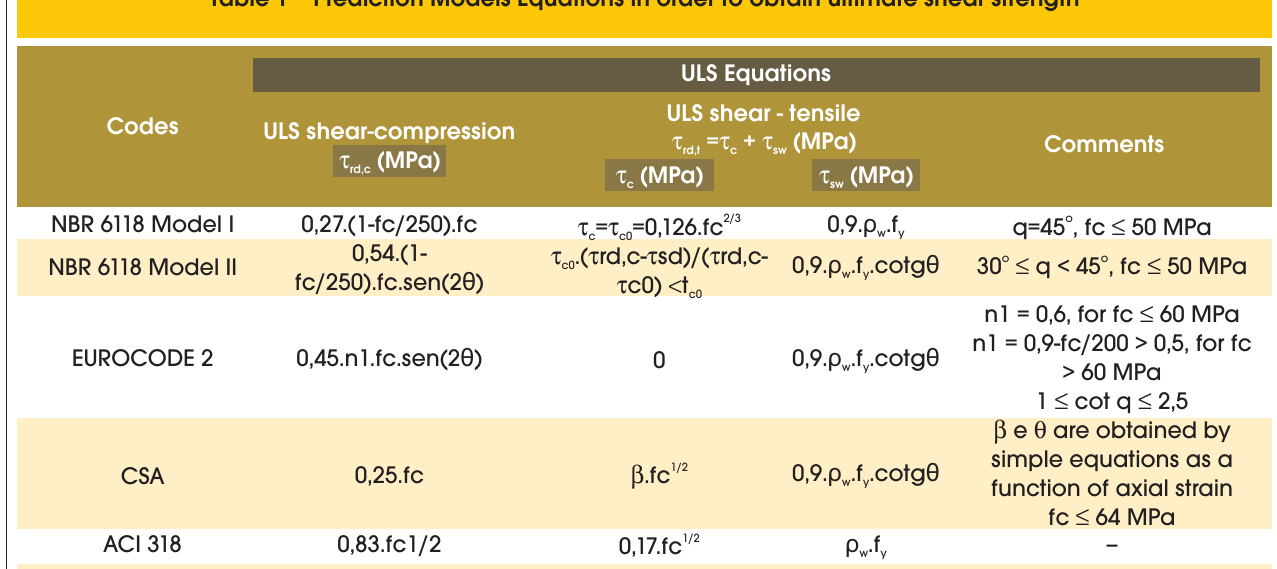
Table 1 – Prediction Models Equations in order to obtain ultimate shear strength